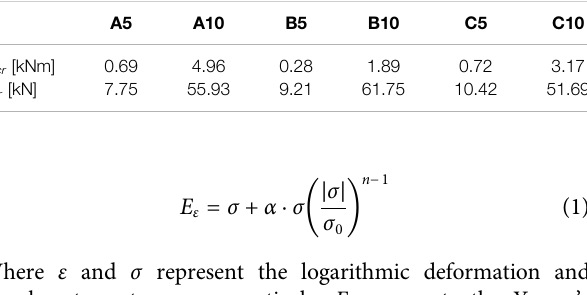
TABLE 1 | Calculation of buckling with Eq. 2 for each con fi guration of